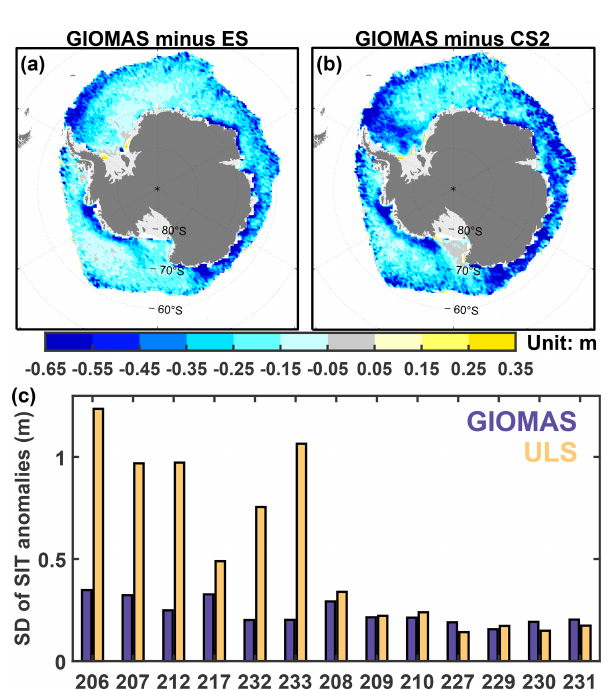
Figure 7. (a) The spatial differences in standard deviation of SIT anomalies between GIOMAS and ES. (b) Same as (a) but for dif- ferences between GIOMAS and CS2. (c) The standard deviation of SIT anomalies for ULS (yellow) and corresponding GIOMAS